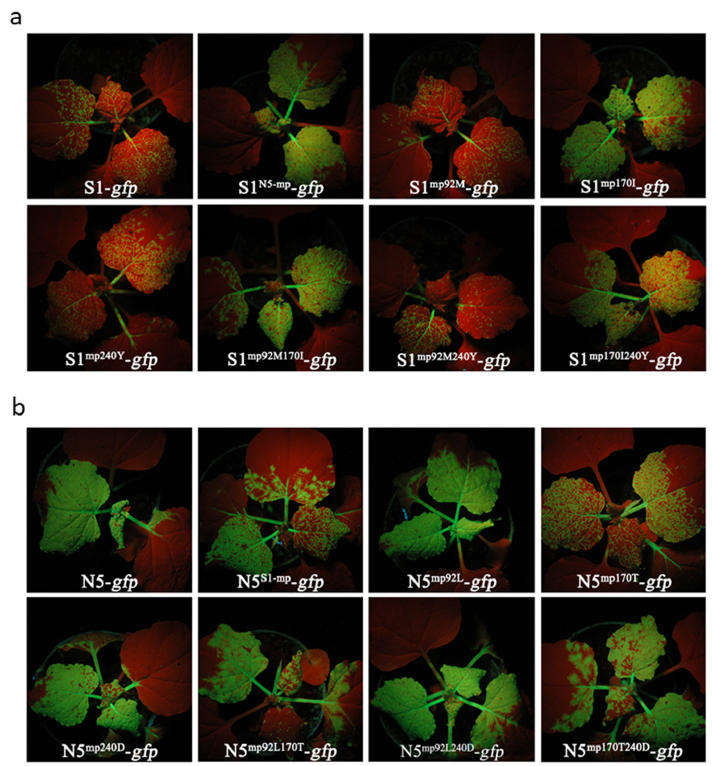
Figure 6. Differential green fluorescence intensities produced by S1- gfp and its MP mutants ( a ), or N5- gfp and its MP mutants ( b ) in Nicotiana benthamiana . The fifth true leaves were inoculated with viruses via agroinfiltration. Plants were photographed under UV light at 8 dpi.